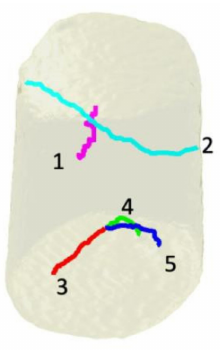
Figure 6. The 3D arrangement of 5 dislocation lines in a portion of a tungsten crystal. Image made from a combination of 6 independent reconstructions of (110) Bragg peaks [53]. Reprinted from